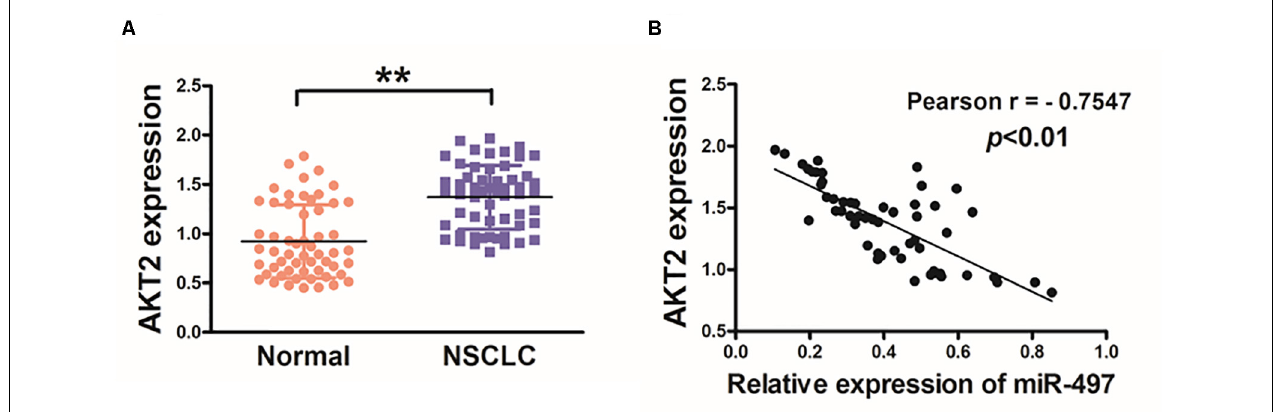
FIGURE 3 | Lung cancer tissues exhibits higher levels of AKT2 which are inversely correlated with miR-497 expression. (A) The expression levels of AKT2 in normal tissues and human NSCLC specimens were determined by qRT-PCR analysis and fold changes were obtained by the ratios of AKT2 to GAPDH levels. (B) Pearson’s correlation analysis was used to determine the correlation between the expression levels of AKT2 and miR-497 in human NSCLC specimens. Data were presented by mean ± SD. of 3 replicates. **indicated P < 0.01.